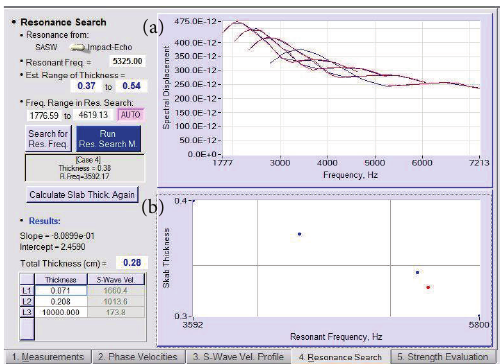
Figure 11: Analysis of resonant frequency search. (a) Spectral spectrumshiftedgraphforthicknessassumptions(setupfourorfive different layering systems). (b) Relationship between the thicknesses of the structure layer and the resonant frequency (red dot represents the thickness of asphalt surface